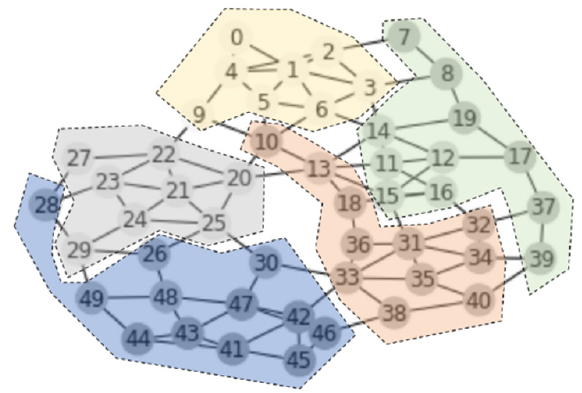
Figure 5. An example of reliable area identification.